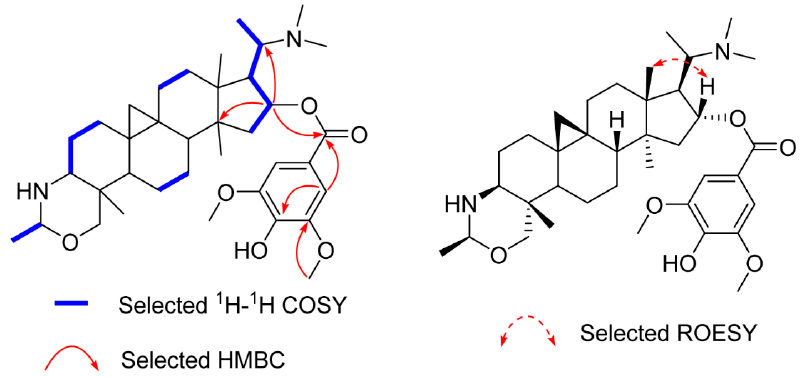
Figure 3. Key 2D correlations of 2 .